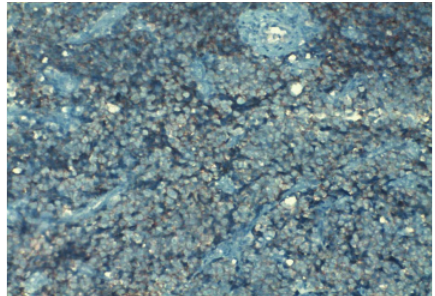
Figure 2: Observed structures, all of which were of tumoral quality. Patchy vascular structures were apparent. Frequent mitotic activities were present. Tumor cells consisted of atypical cells with uniform nuclei and narrow cytoplasm, and some with vesicular nuclei. Immunohistochemical studies showed a positive staining with CD56.